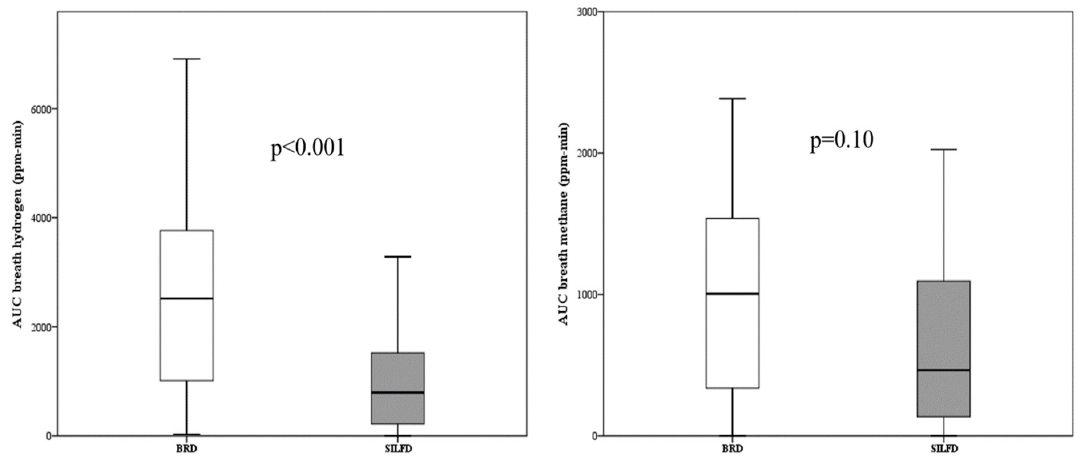
Figure 4. Area under the curve (AUC) of breath hydrogen concentration and breath methane concentration over the 4-h post-prandial period at the fourth week of all patients, comparing between structural individual low-FODMAPs diet advice (SILFD) and brief advice on a commonly recommended diet